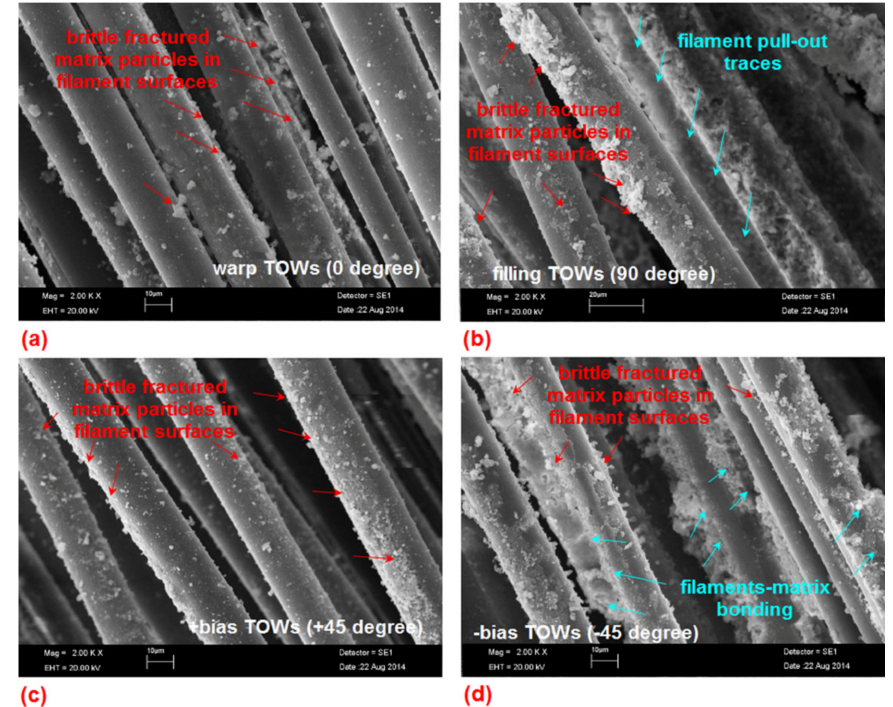
Figure 22. SEM graphs of failed multiaxis 3D basalt fiber concretes. ( a ) Basalt warp surface in the B-4D (the scale bar 10 µ m, magnification × 2000); ( b ) enlarged view of the fractured fiber-matrix in filling in B-4D (20 µ m, × 2000); ( c ) fractured matrix in bias fiber (+45 ◦ direction) in B-4D (10 µ m, × 2000); ( d ) fractured matrix in bias fiber ( − 45 ◦ direction) in the B-4D concrete (10 µ m, ×